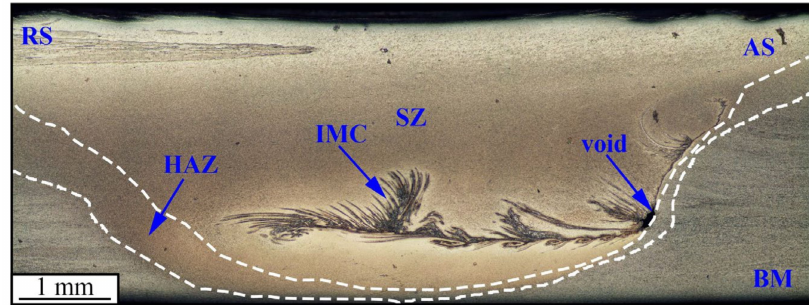
Figure 6. Cross-sectional metallographic image of specimen No. 1.